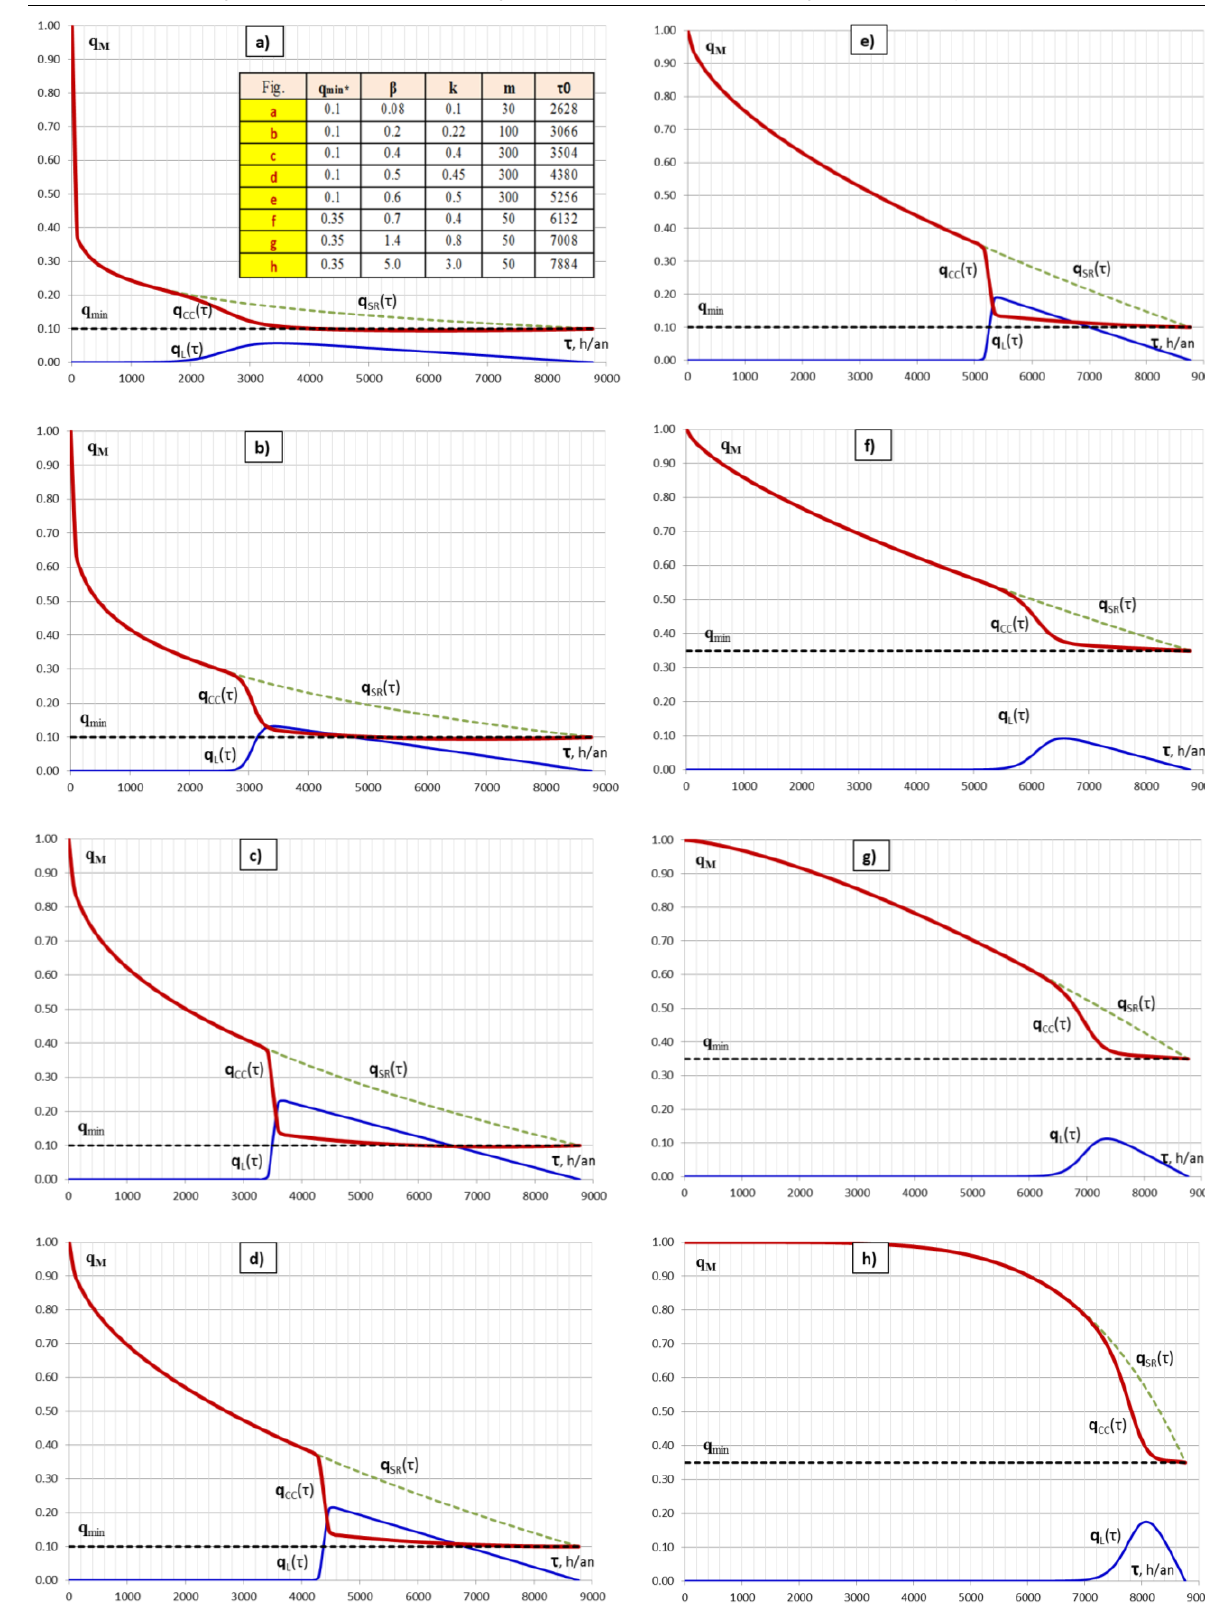
Figure 4. A range of load duration curves, which characterize a large diversity of possible real